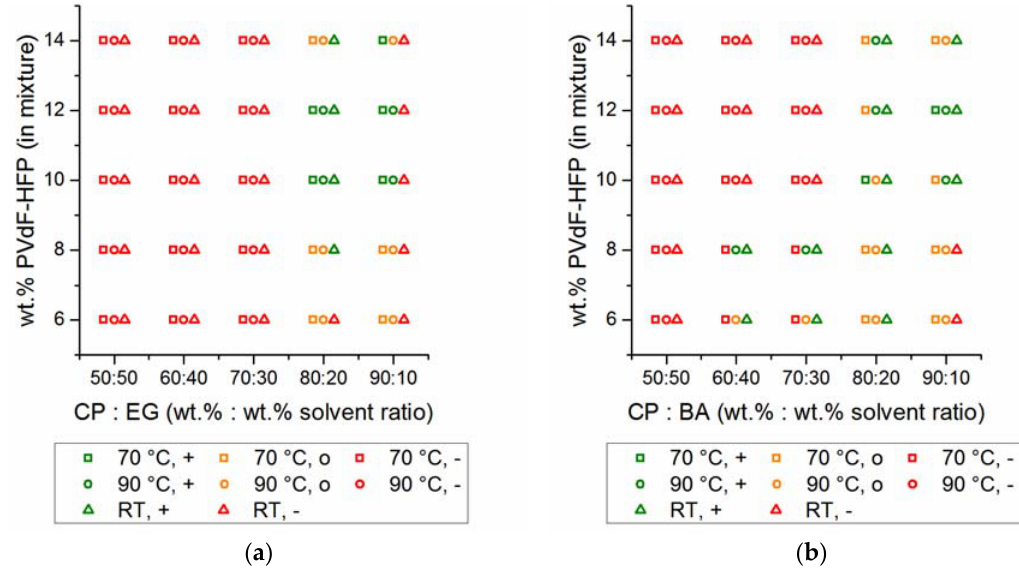
Figure 1. Selected mixtures of ( a ) CP:EG and ( b ) CP:BA, including polyvinylidene difluoride hexafluoropropylene (PVdF ‐ HFP). Symbols are used as follows: square = 70 °C, circle = 90 °C, triangle = room temperature (RT, 25 °C) after cooling from 90 °C. The processability at high temperatures (70 °C/90 °C) is shown in green (appropriate viscosity/homogeneity; 0.5 Pa ∙ s < η < 3.5 Pa ∙ s at a shear rate of 100 s − 1 ), in orange (too high or too low viscosity for processability, which means: η > 3.5 Pa ∙ s at a shear rate of 100 s − 1 or η < 0.5 Pa ∙ s at a shear rate of 100 s − 1 ) or red color (polymer is not dissolved completely, no homogeneous mixture). The consistency at room temperature (after cooling from 90 °C) is shown in green (homogeneous solid) or red (inhomogeneous, not solid, polymer partial precipitated).